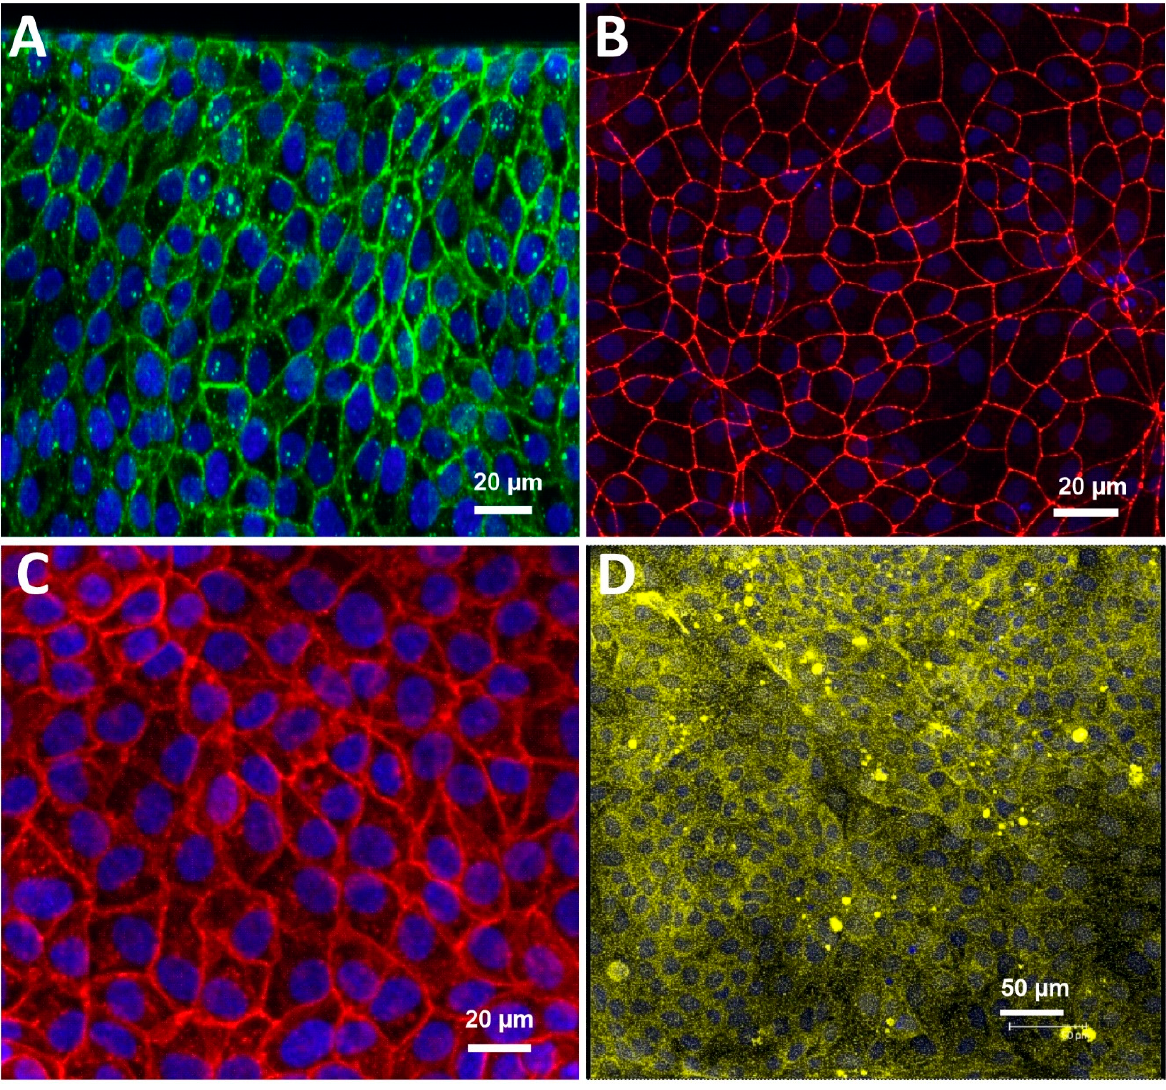
Figure 1. Immunofluorescence images presenting key markers of iBMEC microfluidic chip on day 3. ( A ) Claudin-5, ( B ) ZO-1, ( C ) glucose transporter-1 (GLUT1), and ( D ) P-glycoprotein (P-gp). Nuclei visualized with 4 ′ ,6-diamidino-2-phenylindole (DAPI) in blue.